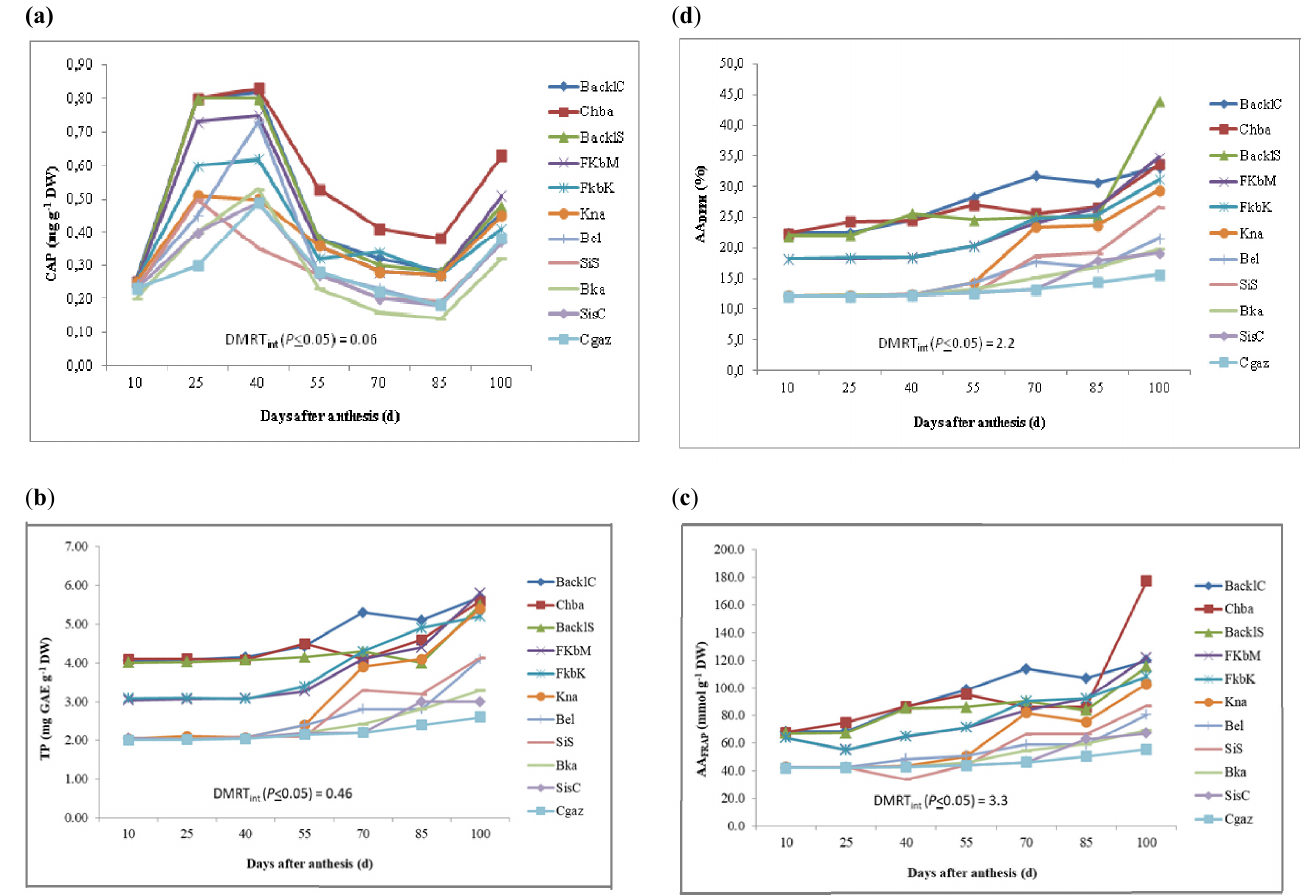
Figure 3. Variation in phytochemical compounds and antioxidant activity (by DPPH and FRAP assays) in the eleven Tunisian chili pepper accessions in relation to harvest time. CAP: capsaicin content ( a ). TPC: total phenol content ( b ). AADPPH and AAFRAP: antioxidant activity by DPPH ( c ) and FRAP ( d ) assays, respectively.